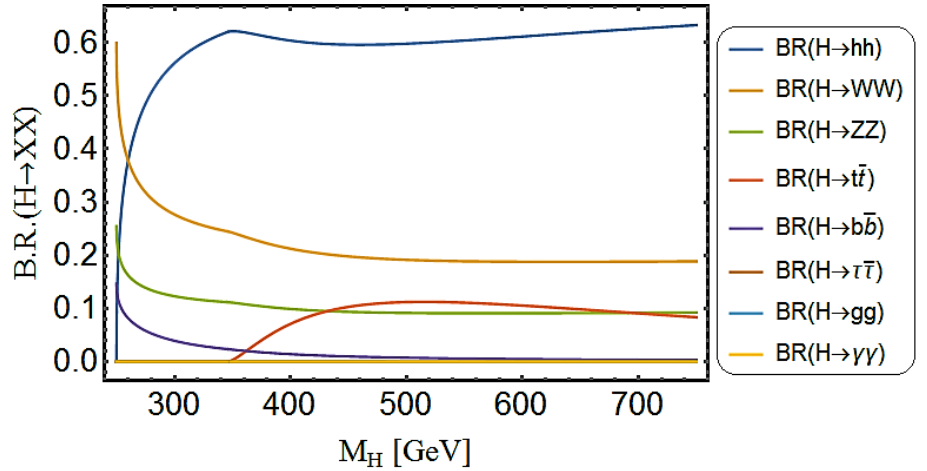
Figure 7 . Branching ratios of H as a function of its mass M H